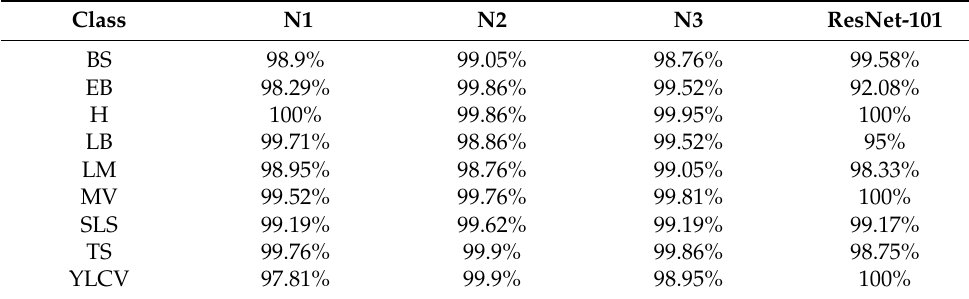
Figure 14. ROC for the ResNet-101, N1, N2, and N3 models. The average precision (AP) is an essential parameter in a detection or classification task; it is the area under the precision–recall curve. The AP for the nine classes is shown in Table 7 for the PV dataset. Table 7. Average precision of each class of tomato leaf